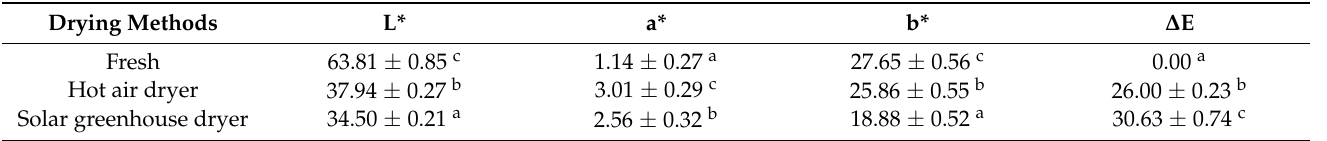
Table 1. Color characteristics of fresh and dried mango slices from different drying